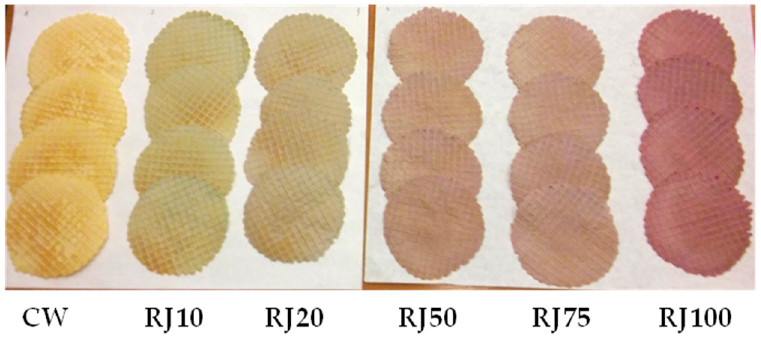
Figure 1. Control wafers (CW) and wafers fortified with raspberry juice (RJ10–RJ100, from 10% to 100% water substitution with raspberry juice, respectively). Table 2. Sensory evaluation of control and fortified wafers, assessed using a five-point hedonic scale (1: bad; 5: very good). Quality